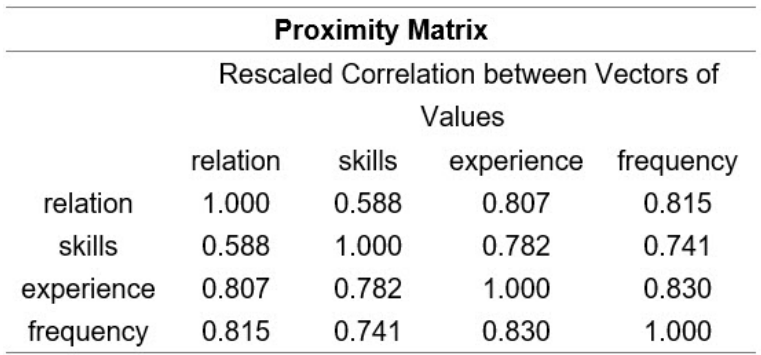
Similarity matrix (created with IBM SPSS Statistics based on Pearson’s correlations)